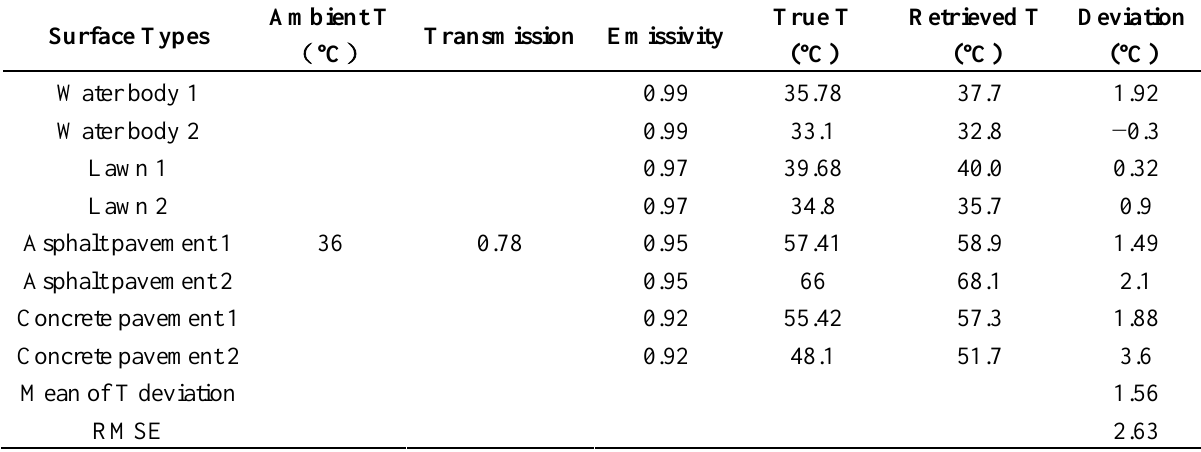
Table 1. Accuracy and deviation of the retrieved LSTs and ground surface